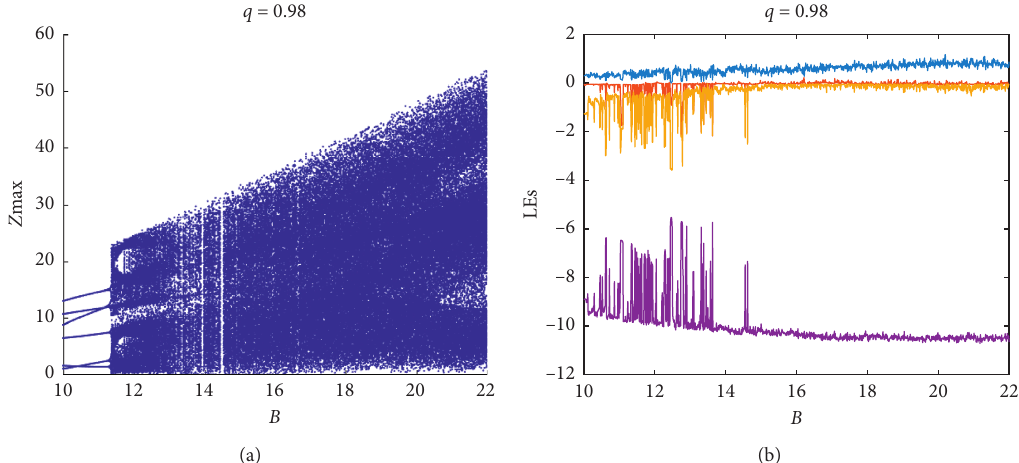
Figure 6: (a) Bifurcation diagram of parameter B of system (1) with q � 0.98; (b) Lyapunov exponent spectrum of parameter B of system (1) with q � 0.98.